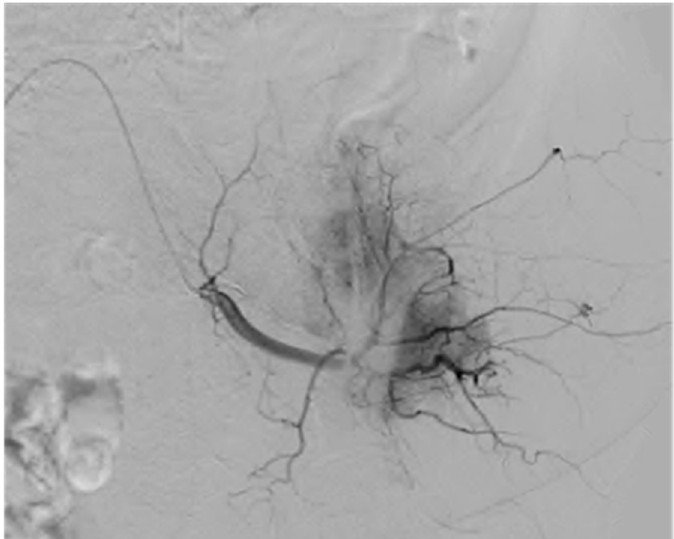
Figure 6. Digital subtraction angiography in a case of a metastatic renal carcinoma lesion in the left acetabulum. During the embolization procedure, there is significant tumoral vascular blush, denoting extensive intratumoral vessel formation.